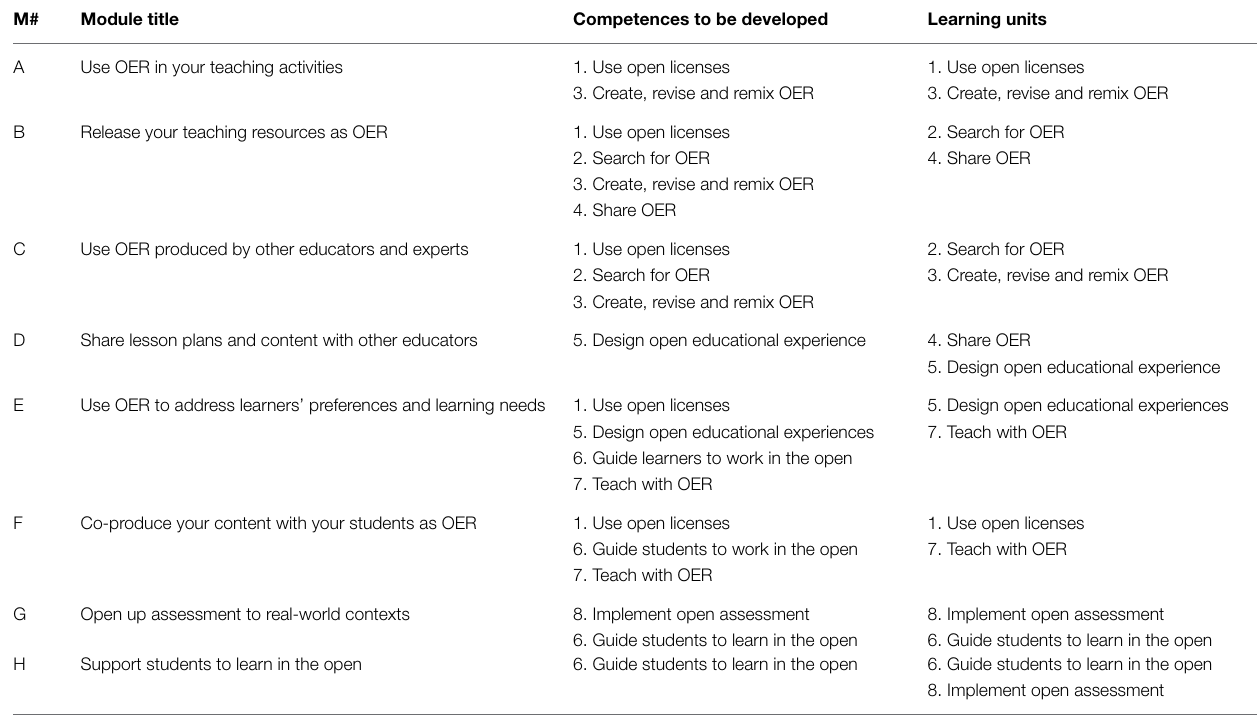
TABLE 1 | Module identification, module title, competences, and learning